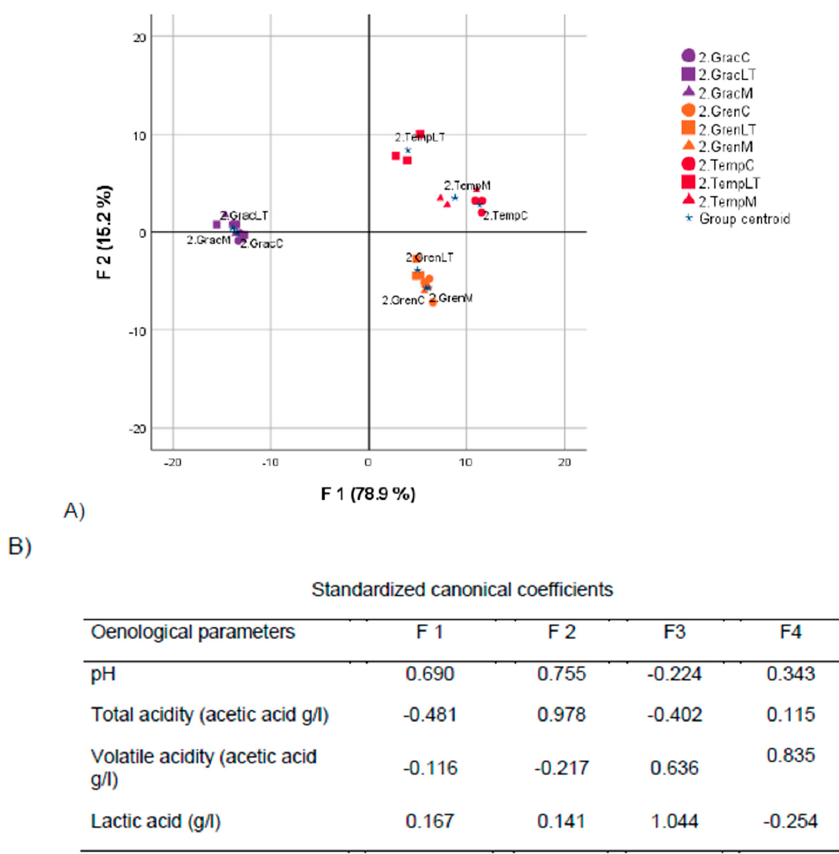
Figure 4. ( A ) Canonical discriminant graph of oenological parameters in control samples (C), samples early inoculated with M. pulcherrima (M) and samples early inoculated with a mix of L. thermotolerans & T. delbrueckii (LT), after alcoholic fermentation (2.) of Tempranillo (Temp), Grenache (Gre) and Graciano (Gra) ( B ) Standardized canonical coefficients of the four main discriminant variables in functions (F1 and F2) for oenological